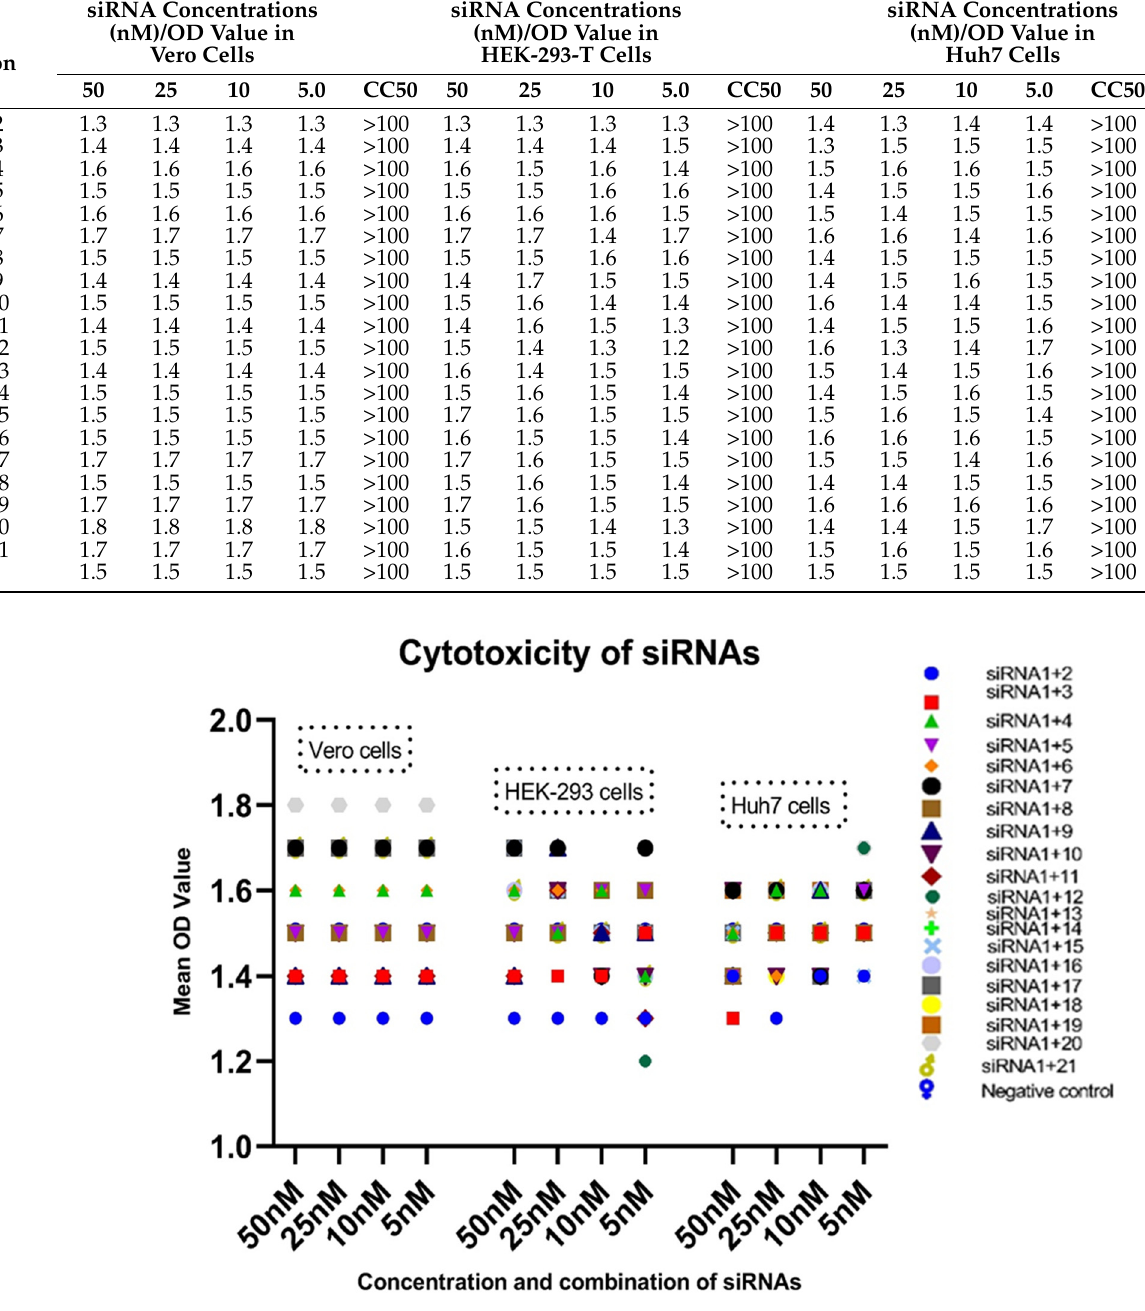
Figure 2. Cytotoxicity of siRNAs in selected cell lines at different concentrations. The variable concentrations of siRNA combinations (50, 25, 10, and 5 nM) were delivered to the grown cell lines. No cell lines showed significant cytotoxicity.